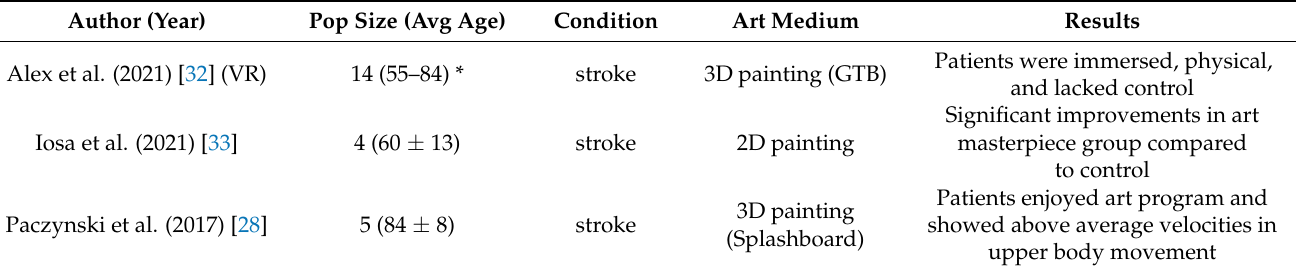
Table 3. Summary of studies using brain injury patients in VR environment.